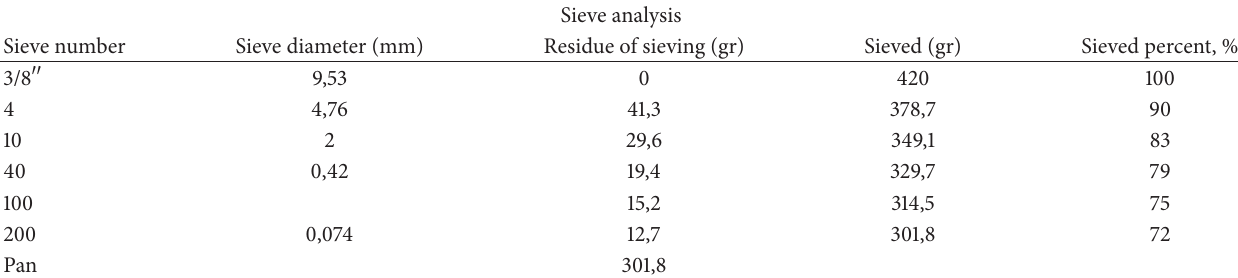
Table 1: Wet sieve analysis.